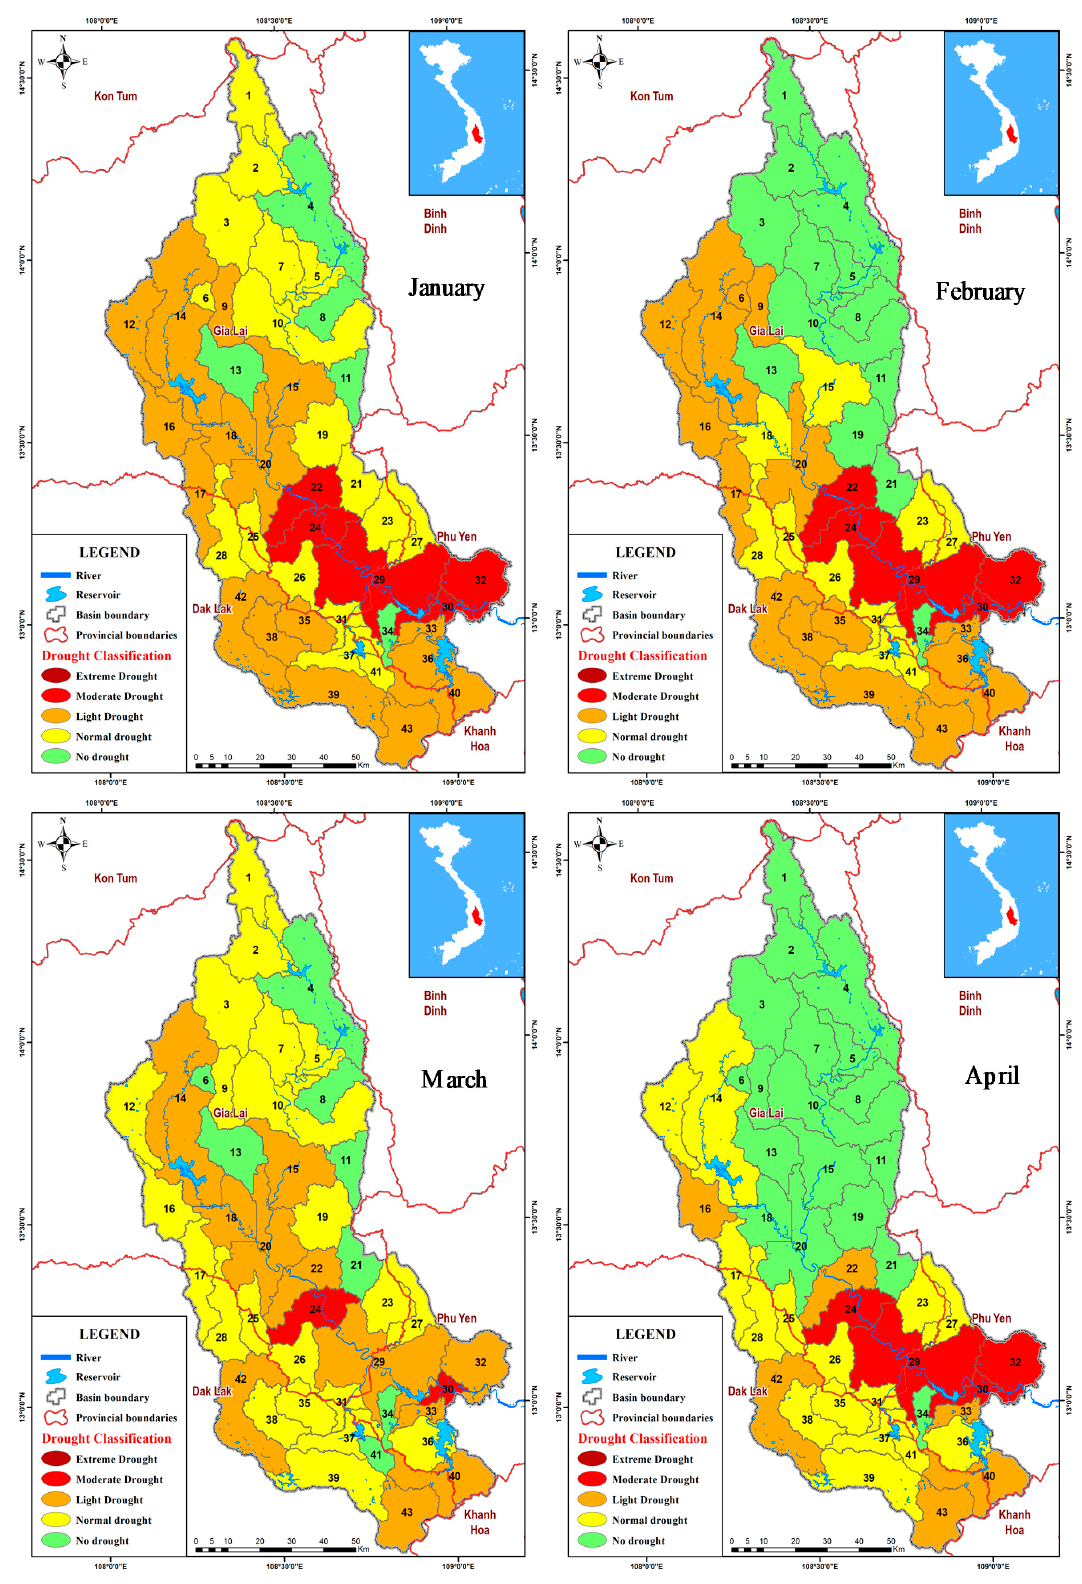
Figure 8. The drought classification maps from January to April in 2016 in the Ba River basin.